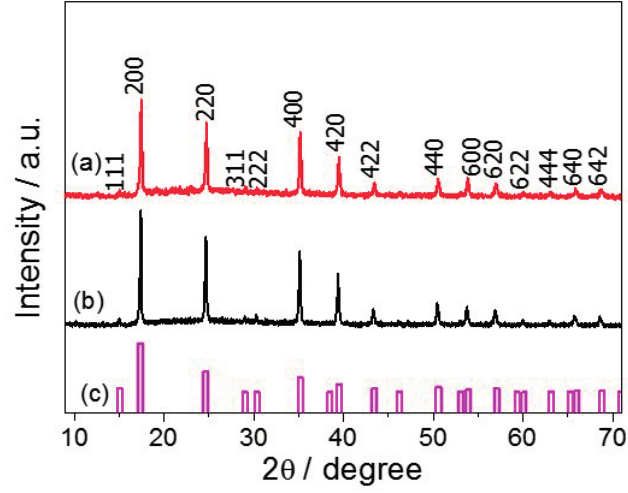
Figure 4. Diffractograms of (a) PBA-CD and (b) PBA nanocubes and (c) crystallographic pattern (JCPDS) of Co 3 [Co(CN) 6 ] 2